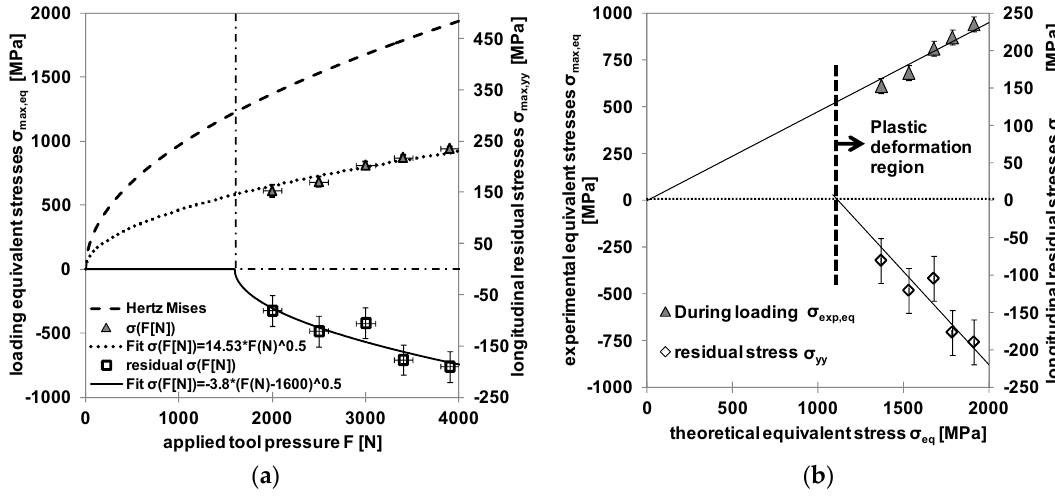
Figure 10. Comparison of ( a ) experimental maximum stresses and ( b ) graphical representation of σ eq , max (0, z ) and σ yy , max ( y , z ) over the maximum theoretical equivalent stress σ eq , theo , max (0, z ).